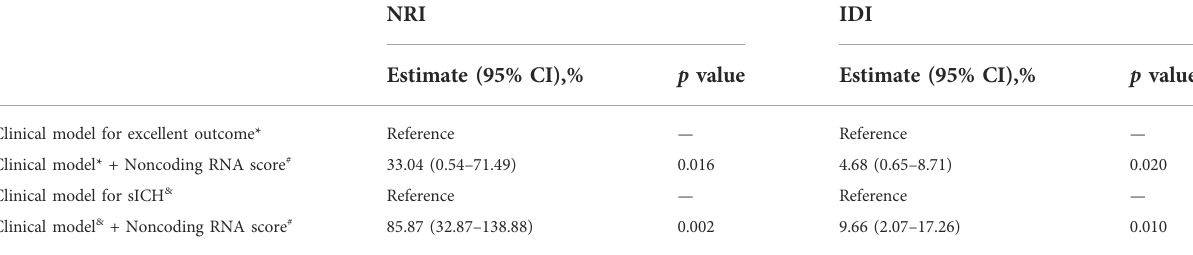
TABLE 3 Reclassi fi cation of the outcomes by noncoding RNA score among AIS patients received rtPA treatment ( n = 103).